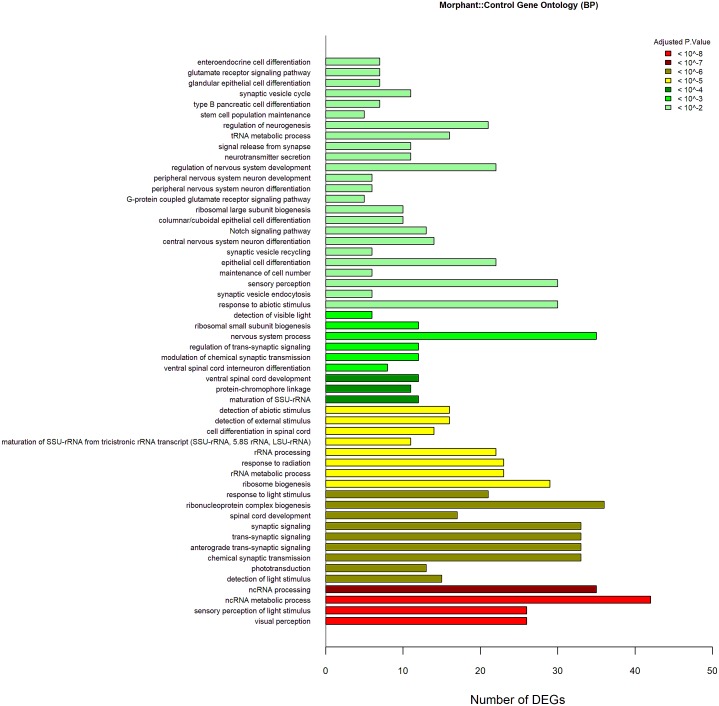
GO Analyses knockdown Vs. Control.Gene Ontology biological process enrichment results (P < 0.01) from lepa knockdown compared to control; the barplot contains 54 enriched terms. Color scale reflects adjusted p.value; the x-axis denotes the number of DEGs that map to each enriched term.